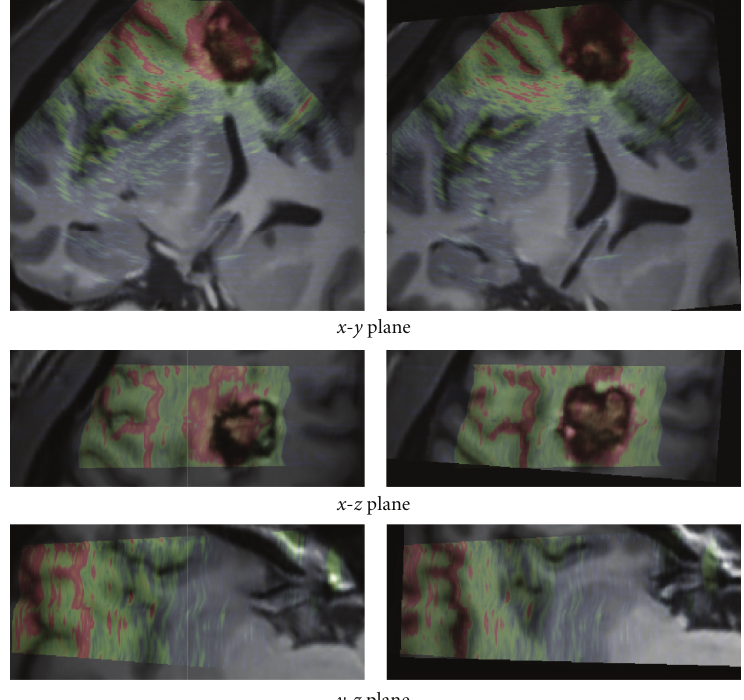
Figure 6: Patient 2. Left: registration given by the neuronavigation system. Right: results after correction with our registration approach. The low intensities of US images are in green and the high in red. In this case, the acoustic shadow artifact was present on the US image. The signal below the lesion was totally dark as shown in Figure 3. The proposed approach allowed to overcome these artifacts without specific detection of the